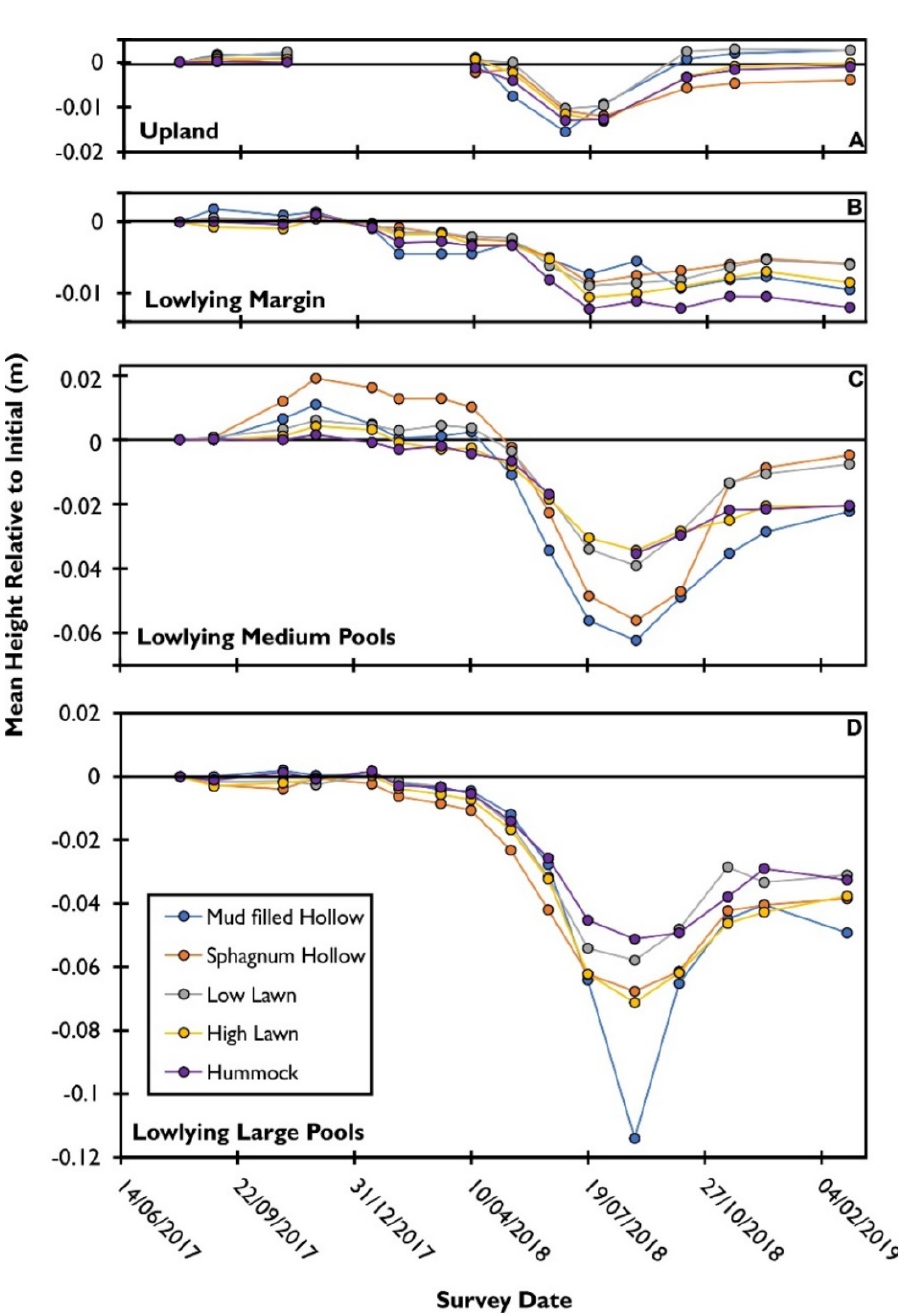
Figure 3. Precise Leveling Measurements of mean motion of benchmarks within different microto- pographies at ( A ) upland ( B ) Low-lying margin ( C ) Low-lying medium pool ( D ) and low-lying large pool sites.